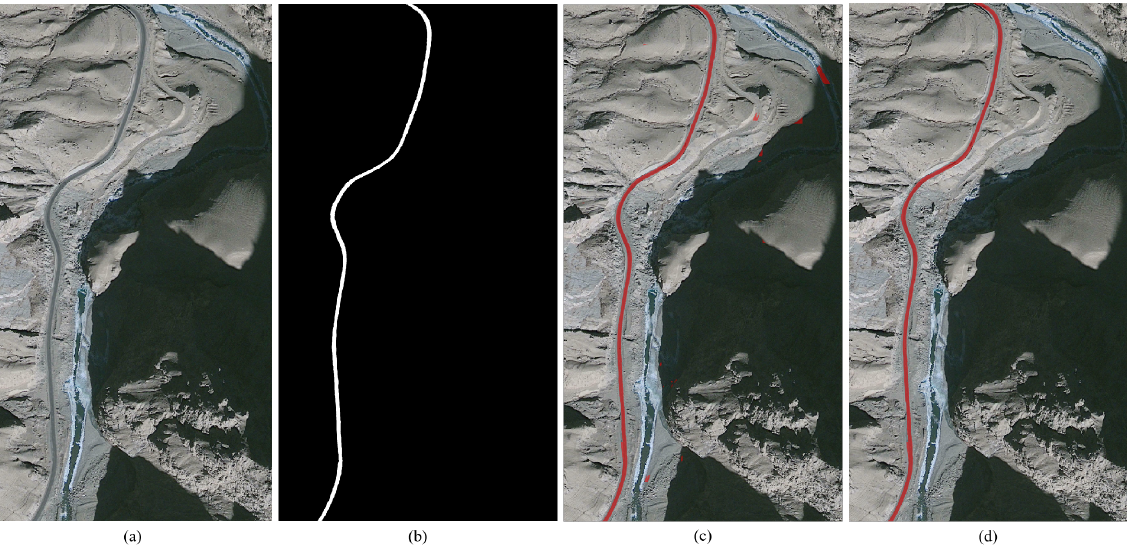
Figure 9. The second image result used for prediction. ( a ) is the original imagery; ( b ) is the manual road label; ( c ) is the prediction roads of Light Roadformer; ( d ) is the prediction after post-process.